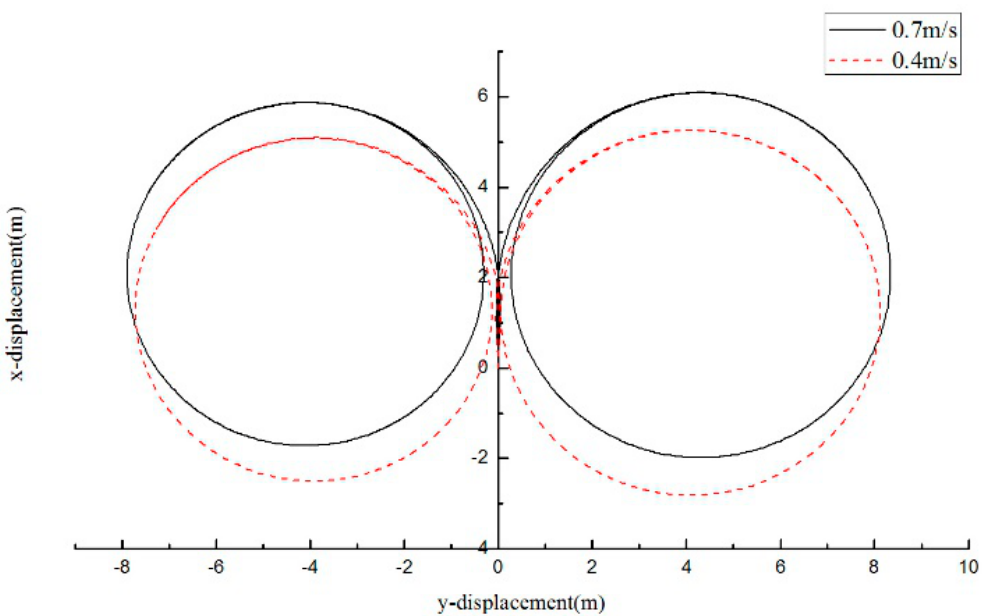
Figure 8. Trajectory in the turning test recorded by Differential Global Positioning System (DGPS).